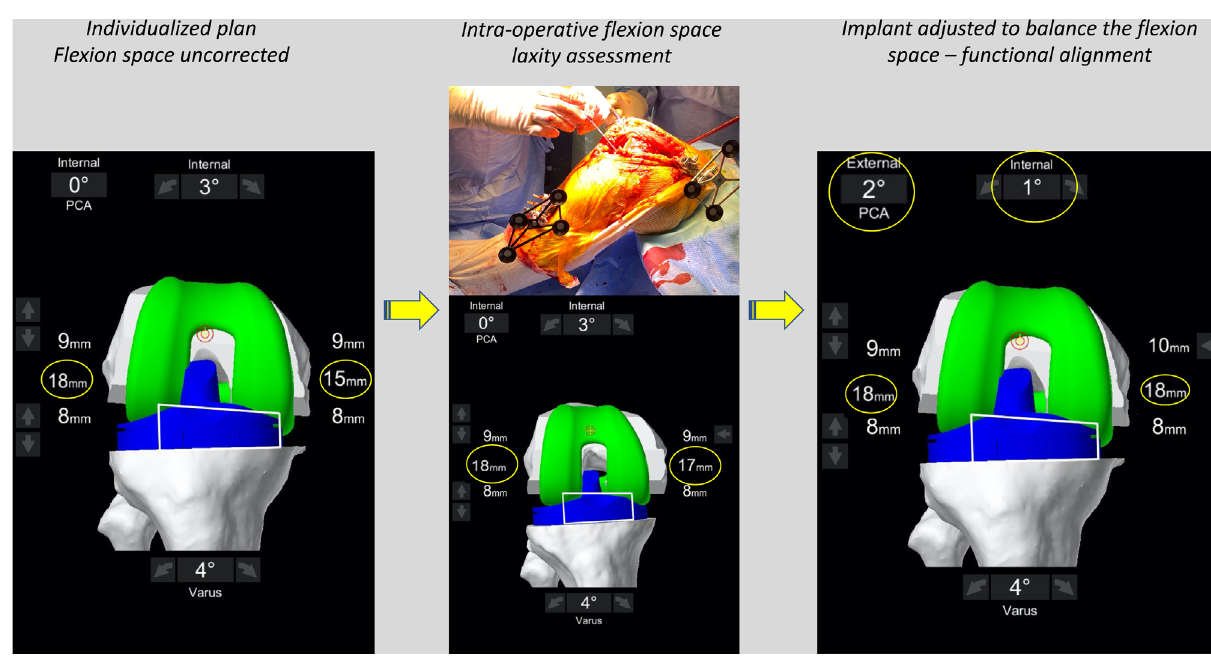
Figure 5. The fl exion space before correction. The fl exion space is assessed using sized spacer spoons until the corrected position is achieved. The personalized plan will deliver a medial space of 17 mm and lateral space of 18 mm. In order to balance the fl exion space, the implant is externally rotated until the compartments are